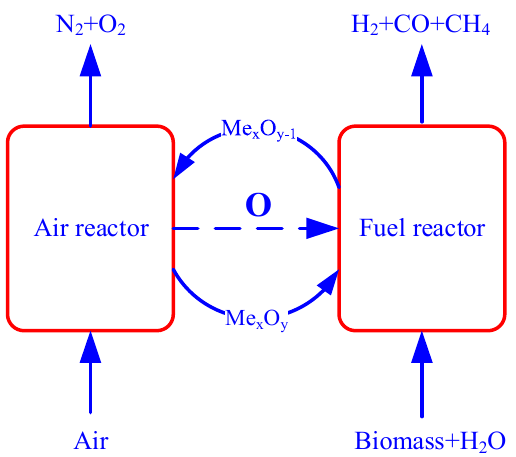
Figure 1. The schematic diagram of chemical looping gasification.